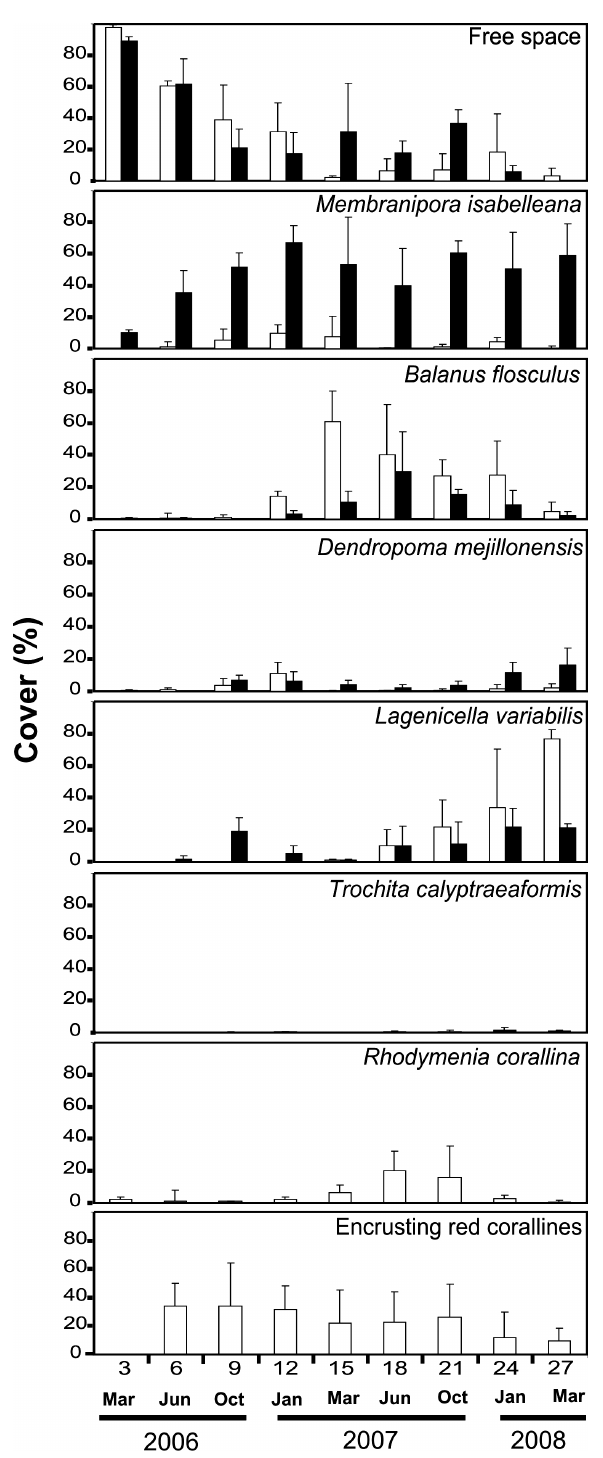
Fig . 2. – Mean percentage (± Sd, n = 3) cover of epibenthic species colonizing exposed (white bars) and hidden (black bars) surfaces during successional development. numbers at the x-axis indicate the months after the panel’s